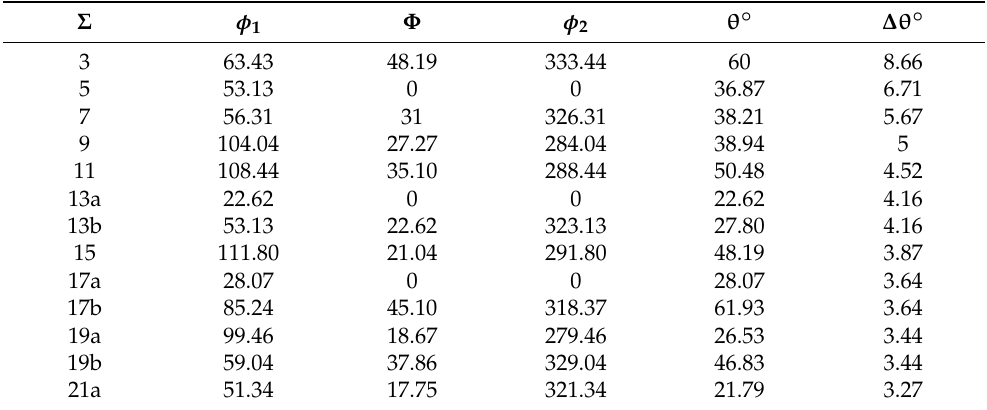
Table 2. List of CSLs ( Σ ≤ 49) with Brandon’s criterion in cubic LLZO (CSL type Σ , Euler